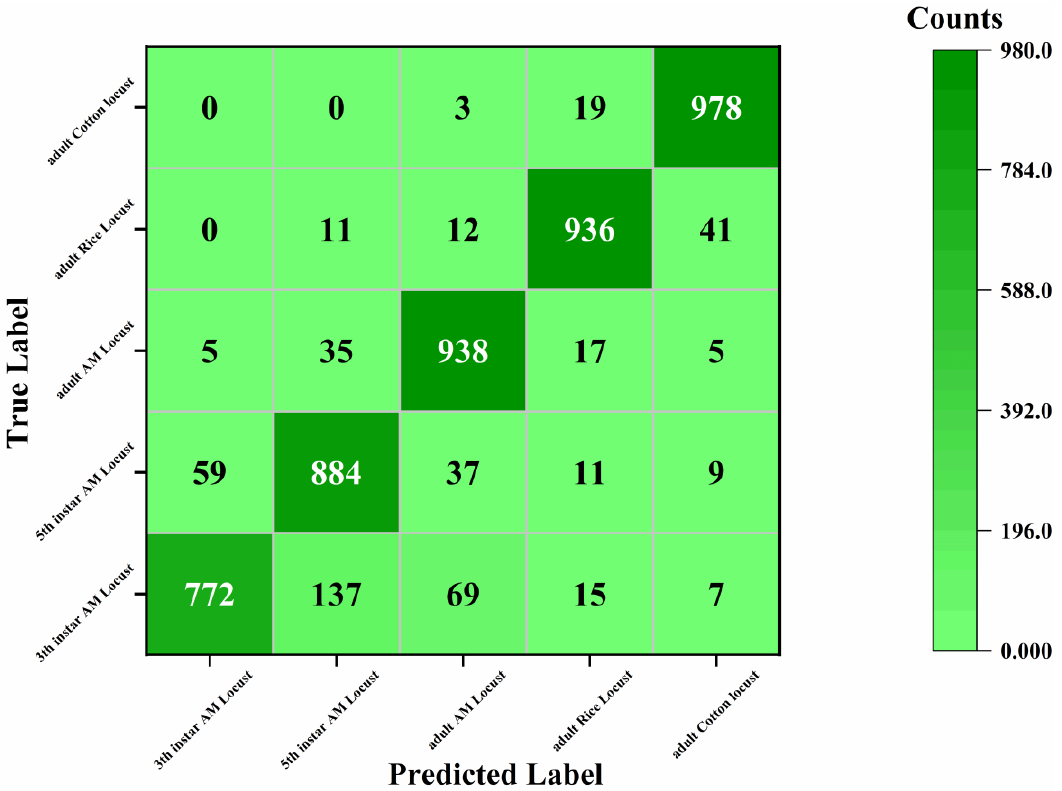
Figure 9. Confusion matrix base on ResNet-Locust-BN model.